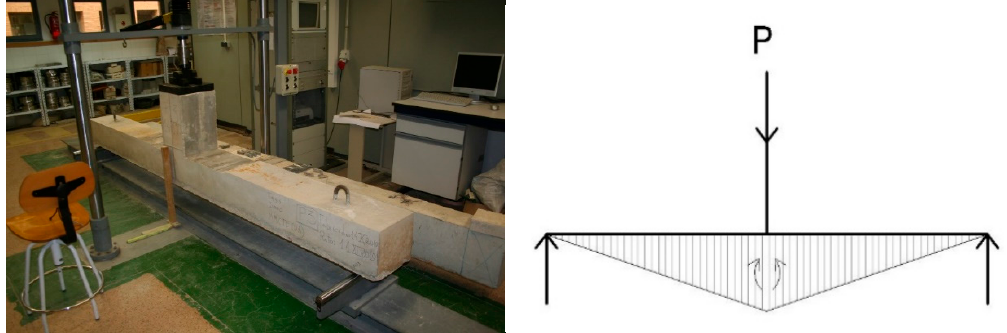
Figure 3. Experimental set-up.